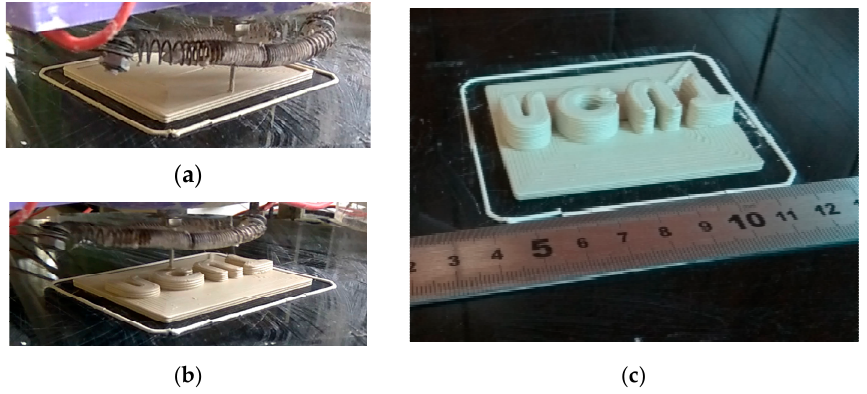
Figure 14. Three-dimensional printing of the multi-parts array with in situ hot air flow drying: ( a ) extrusion-based 3D printing, ( b ) 3D-printing island structures, and ( c ) finalized multi-parts array.